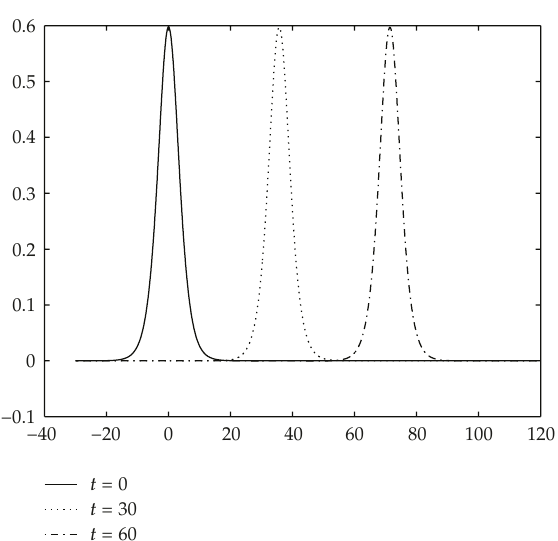
Figure 2: Exact solutions of u (cid:5) x,t (cid:6) at t (cid:7) 0 and numerical solutions computed by scheme (cid:5) 2.3 (cid:6) – (cid:5) 2.5 (cid:6) at t (cid:7) 30 , 60 for p (cid:7) 3.